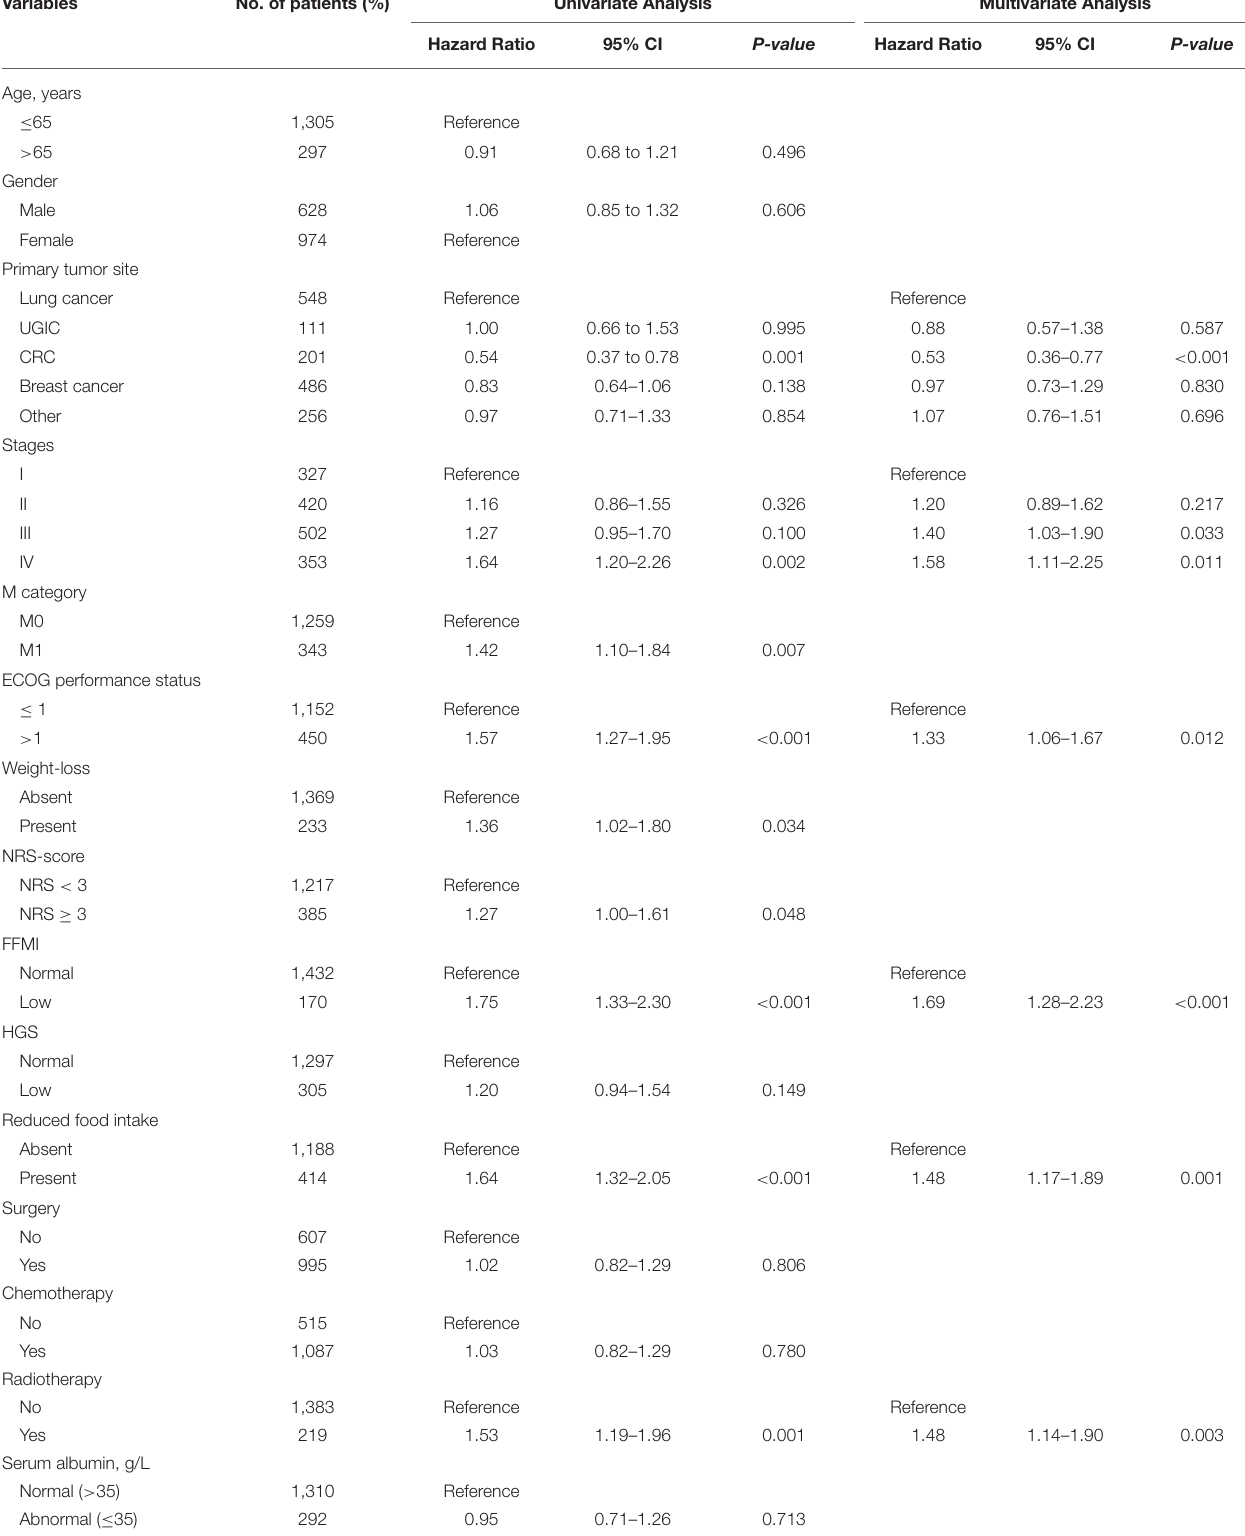
TABLE 2 | Univariate and multivariate Cox regression analysis of OS in cancer patients with normal/high